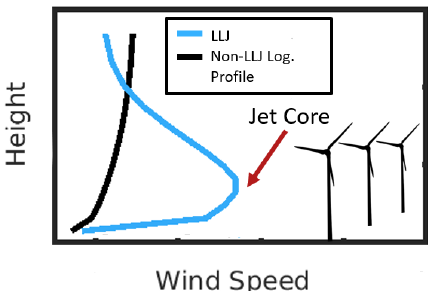
Figure 1. Illustrative graphic comparing a low-level jet (blue) wind speed profile and a standard logarithmic, non-LLJ wind speed pro- file. The wind speed maximum (jet core) in this depiction is at a height below a typical rotor plane, which would result in negative shear across the rotor